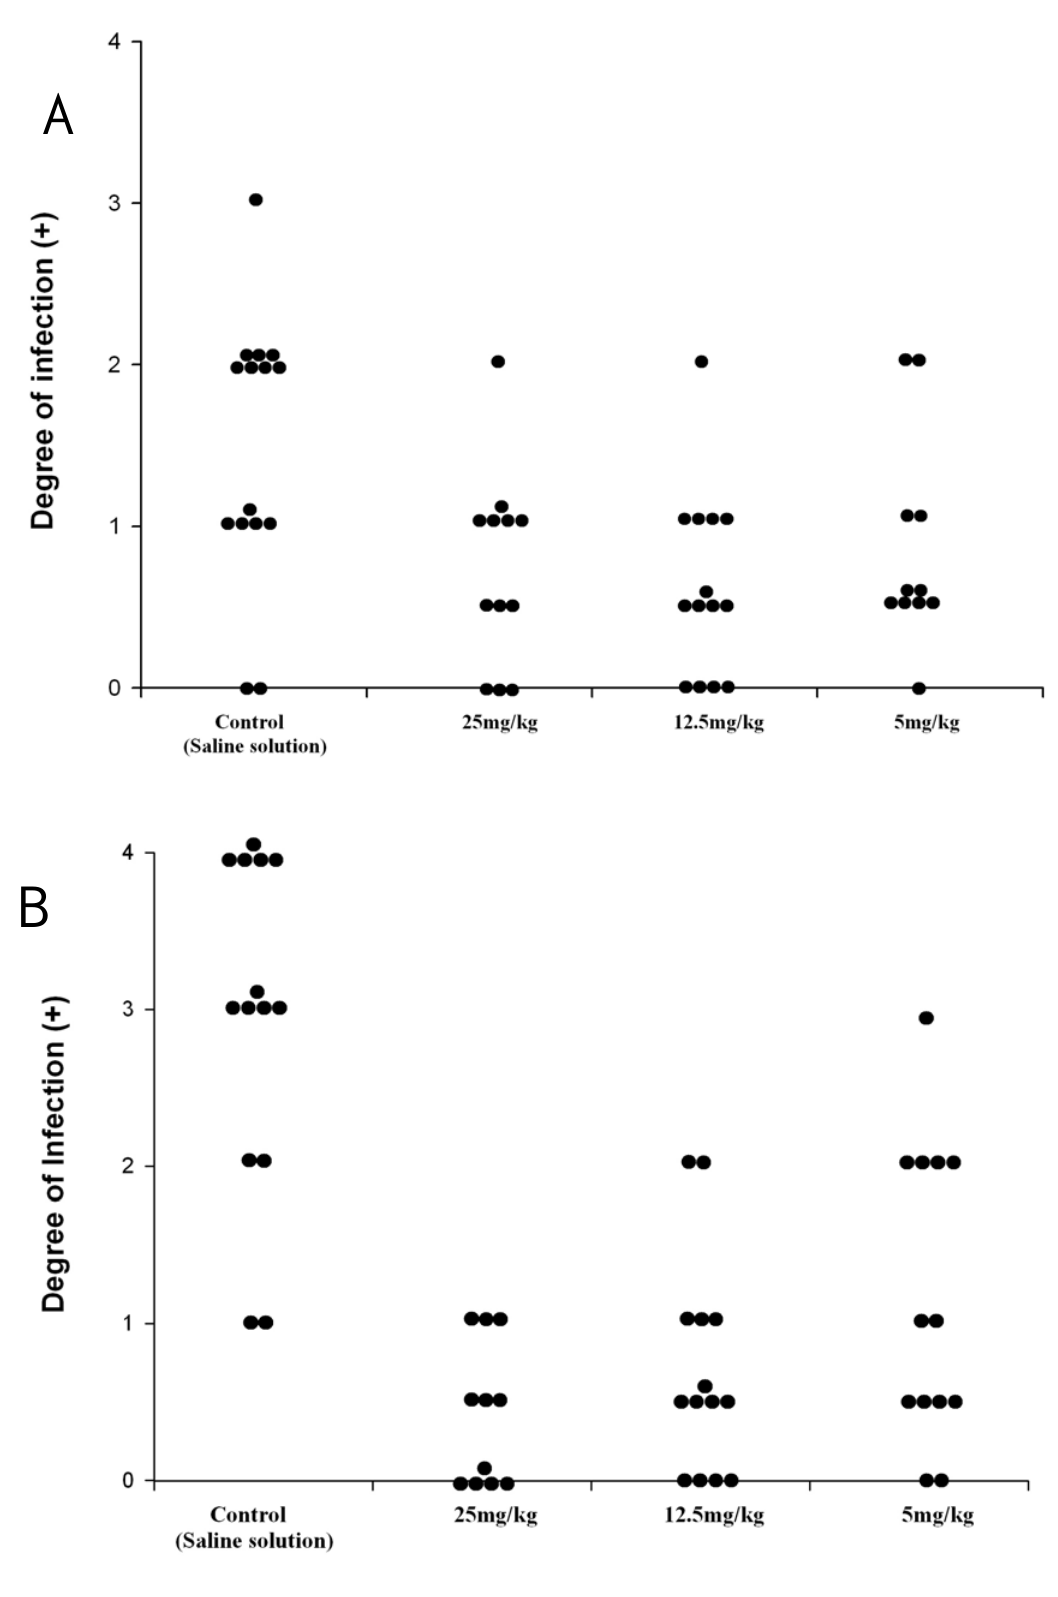
Figure 4. Effect of the prodrug, DA-7218 on the development of mycetomatous lesions on BALB/c mice infected with N. brasiliensis . A: Degree of infection of mice footpad after 3 weeks of therapy. B: Scores after the second cycle of three weeks of therapy. Each point represents the score of one